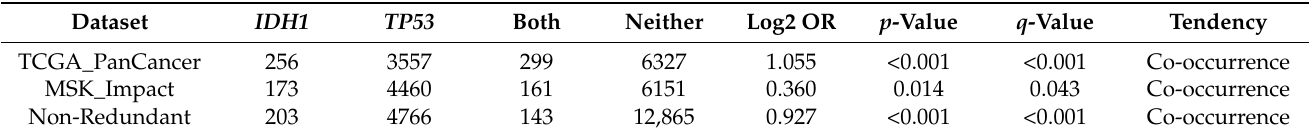
Table 2. Co-occurrence of IDH1 and TP53 alterations in human cancer.